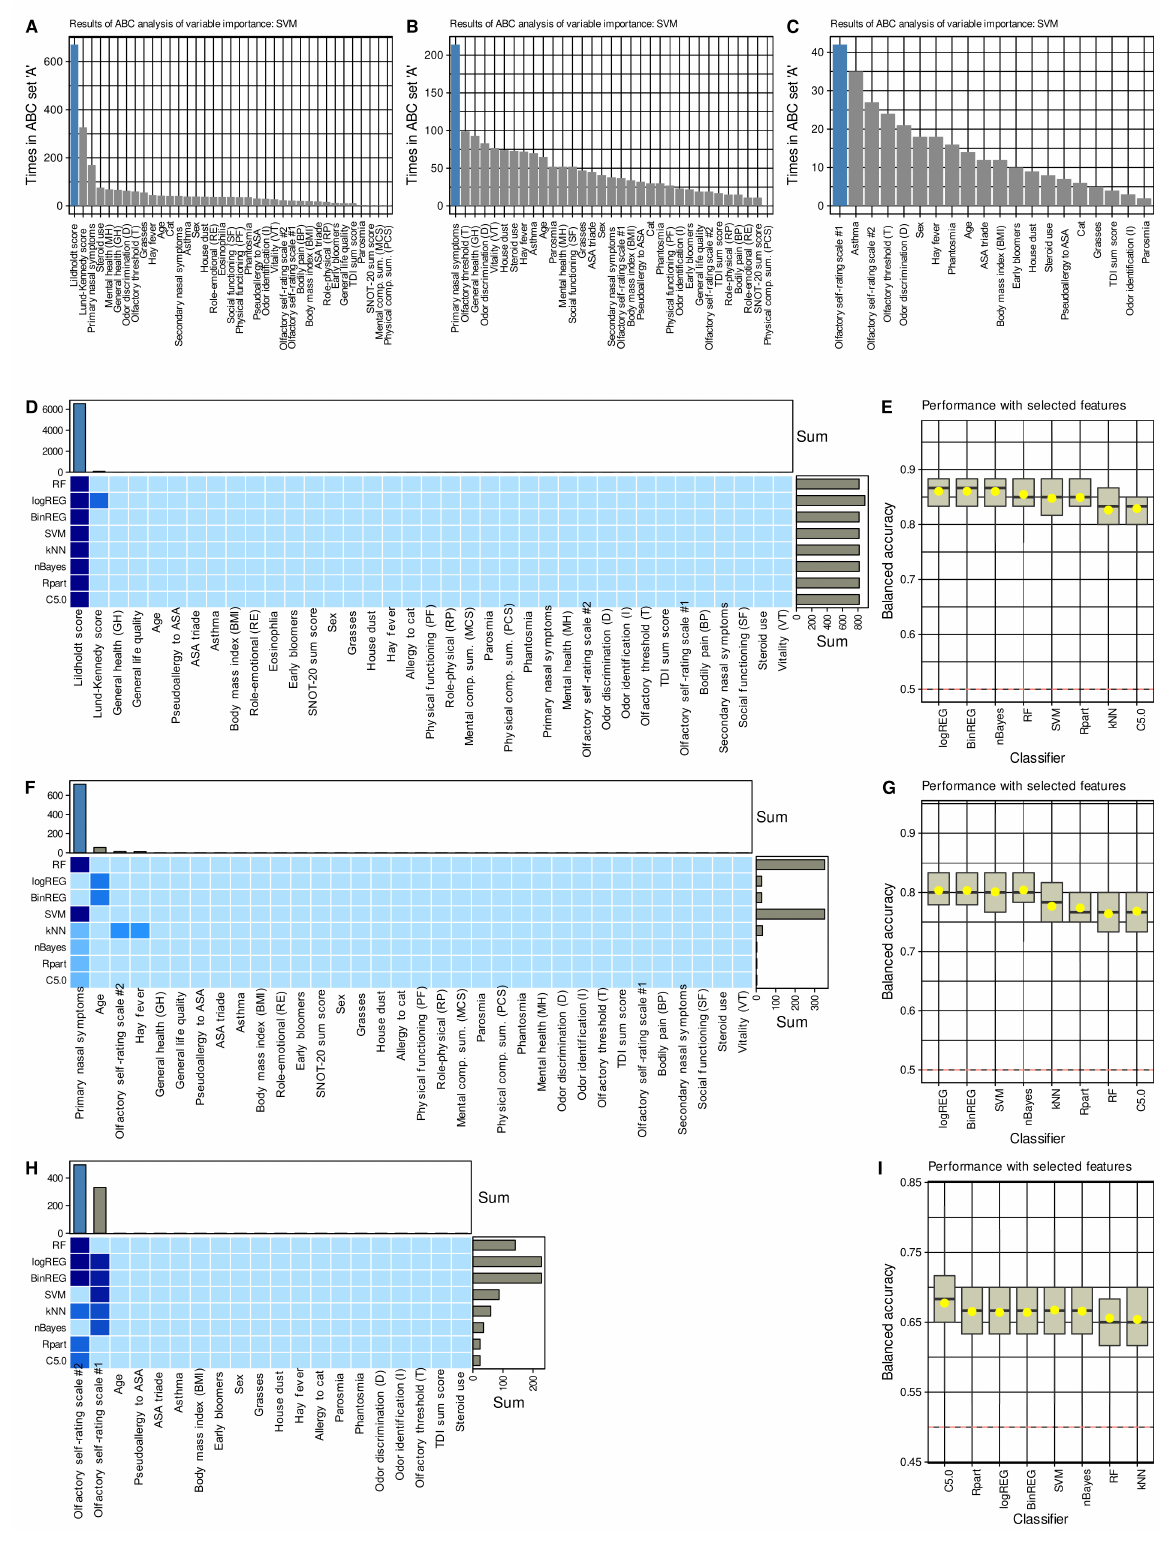
Figure 4. Results of the feature selection process aimed at variables providing relevant information on changes from before to after endoscopic sinus surgery . ( A – C ) Bar plots showing the number at which an item categorization technique implemented as a computed ABC analysis [72] placed the respective variables in ABC subset “A”, i.e., among the most relevant items, during the 1000 cross-validation runs on randomly selected disjoint training and test data sets, analogously to the analyses reported in [71]. The blue bars show the finally selected items based on their occurrence in the relevant